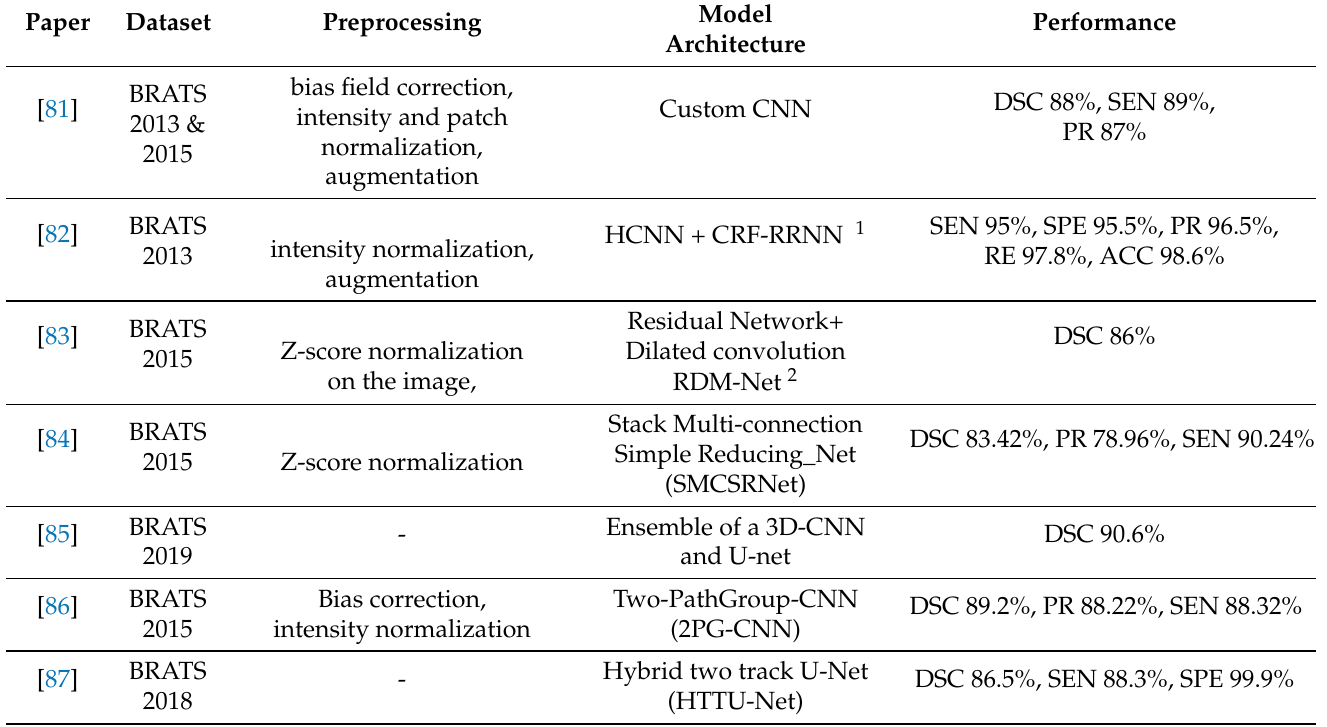
Table 5. Summary of deep learning based brain tumor segmentation